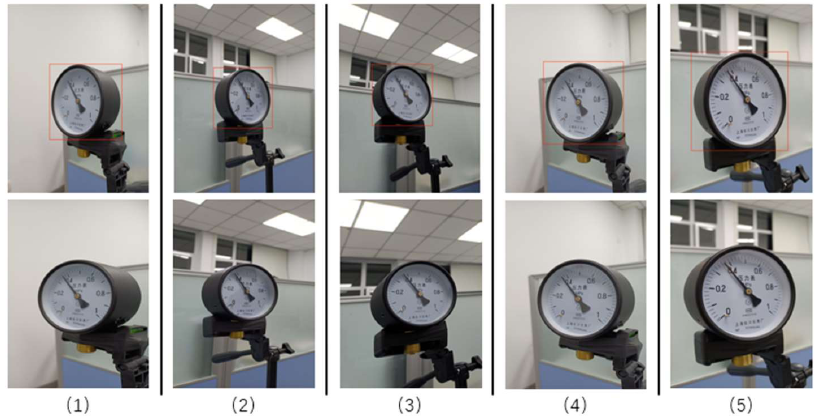
Figure 8. Skew correction